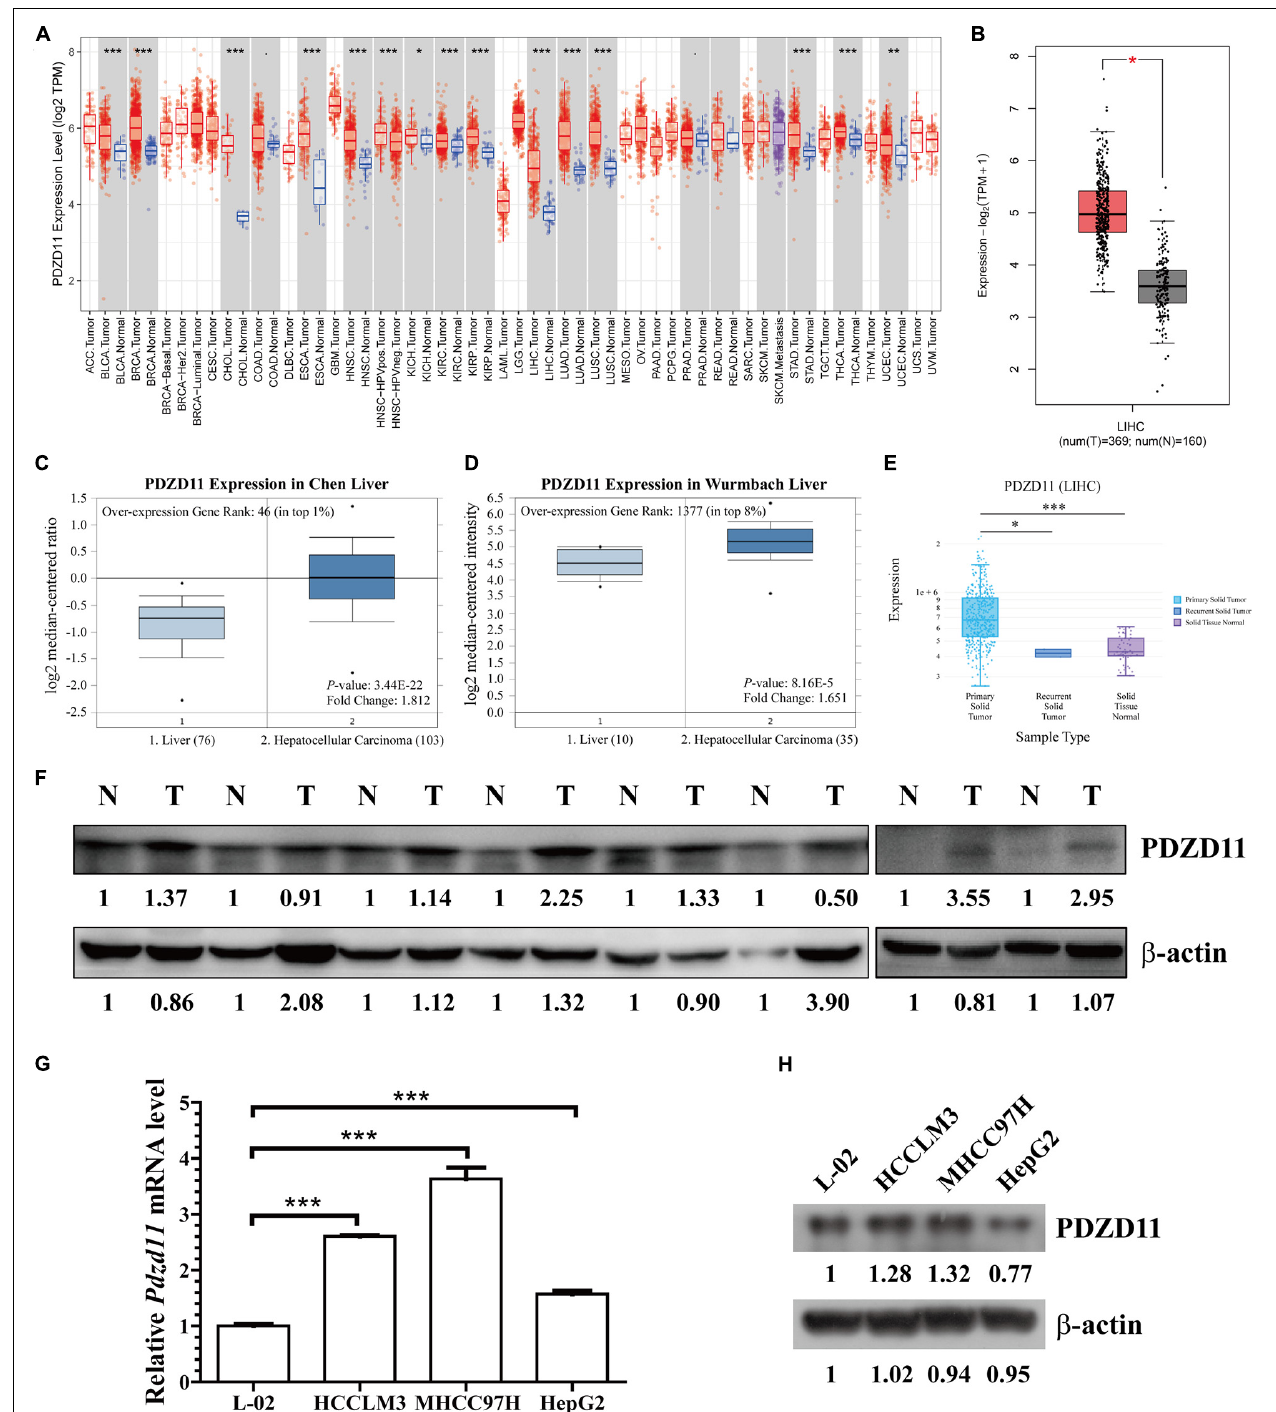
FIGURE 1 | PDZD11 expression levels in LIHC. (A) Transcription levels of PDZD11 in different types of cancers (TIMER database). (B) PDZD11 mRNA expression levels in LIHC tissues and adjacent normal liver tissues from GEPIA 2 database. (C,D) Box plots show PDZD11 mRNA expression in liver (left plot) and hepatocellular carcinoma tissue (right plot) of the Chen Liver (C) and Wurmbach Liver (D) datasets. The fold-change of PDZD11 expression in LIHC was determined using the Oncomine database. The threshold was designed using the following specific parameters: p = 1E-4, fold change = 2, and gene rank 10%. (E) mRNA expression of PDZD11 in primary solid tumors, recurrent solid tumors, and adjacent normal liver tissues (DriverDBV3 database). (F) A representative western blot showing PDZD11 protein is expressed in LIHC tissues (T) and matched normal liver tissues (N) ( n = 8). (G,H) Real-time qPCR and Western blotting analysis of PDZD11 mRNA (G) and protein expression (H) in human hepatocytes and LIHC cell lines. * p < 0.05; ** p < 0.01; *** p < 0.001.